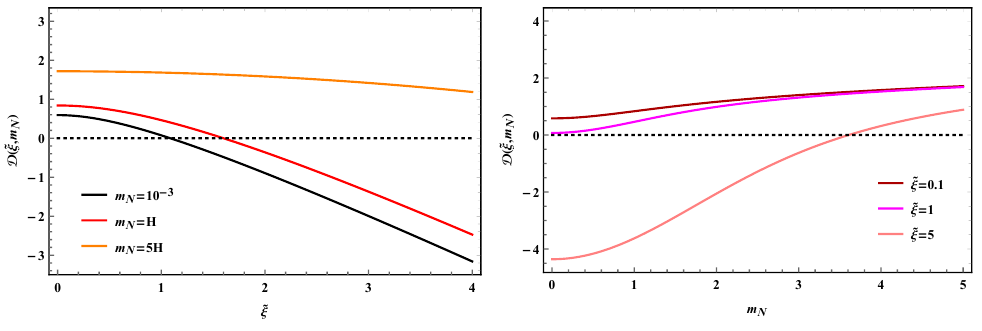
(˜ ) vs ξ (left panel) and vs m ξ, m N i